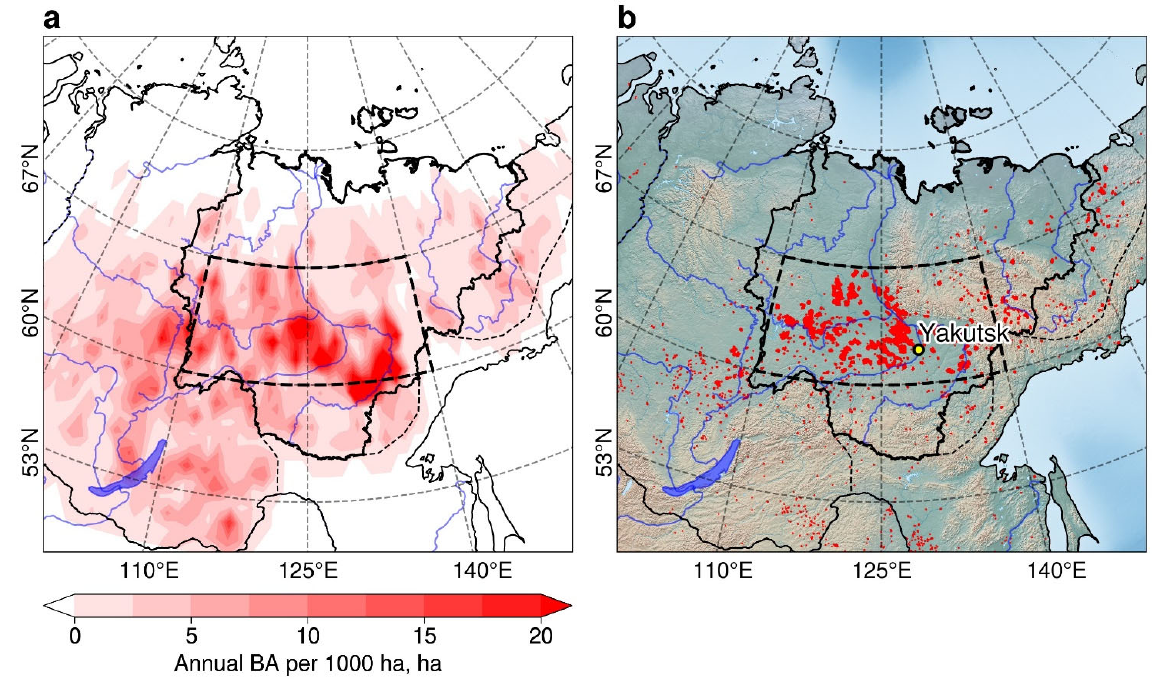
Figure 1. ( a ) Annual mean burned area per 1000 ha in Eastern Siberia during 1984–2016 obtained from ES-BA dataset [30]; ( b ) MODIS hotspots detected during 2021 (red dots). Bold black line—Yakutia, bold dashed black rectangle—study region, thin dashed line—Eastern Siberia, blue lines—rivers.